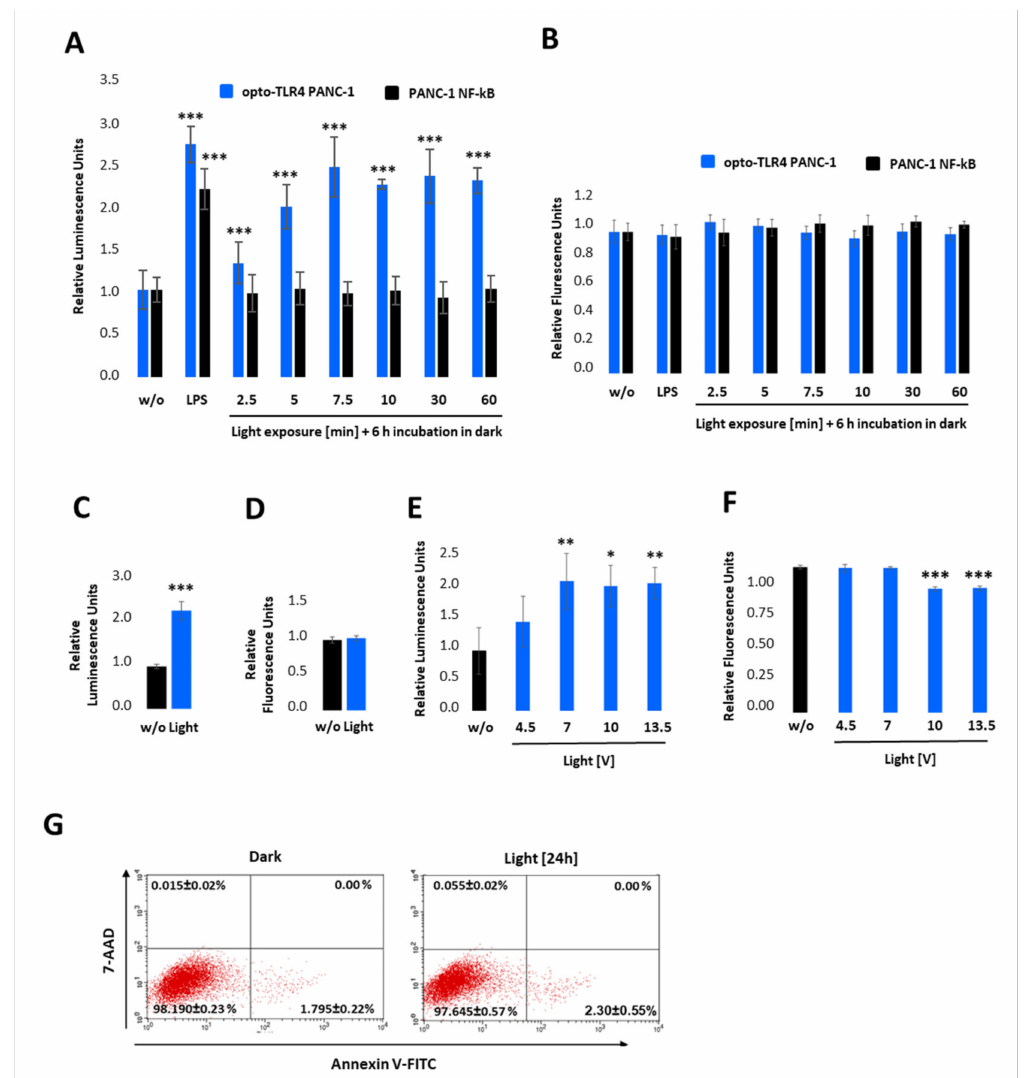
Figure 3. Characterisation of the opto-TLR4 PANC-1 cell line. TLR4-LOV homodimerisation and activation of NF- κ B in response to blue light can be detected in real-time via measuring Gaussia Luciferase (Gluc) activity. ( A , B ) Opto-TLR4 PANC-1 and PANC-1 NF- κ B were stimulated with 100 ng/mL LPS or exposed with light at 470 nm for 0, 2.5, 5.0, 7.5, 10, 30, or 60 min using the Amuza LED Array System, followed by incubation in the dark. After 6 h, ( A ) Gluc activity and ( B ) cell viability (PrestoBlue) were determined. ( C , D ) Opto-TLR4 PANC-1 cells were stimulated with light (470 nm) for 12 h, followed by ( C ) Gluc detection and ( D ) PrestoBlue. ( E , F ) Cells were illuminated with 4.5, 7.0, 10, and 13 V at 470 nm for 7.5 min, followed by incubation in the dark for 6 h and ( E ) relative NF- κ B promoter-linked Gluc and ( F ) PrestoBlue measured. Post-ANOVA multiple comparisons relative to the control were performed using Dunnett’s test. Error bar = SD. n = 6; * p < 0.05; ** p < 0.01, *** p < 0.001. ( G ) To measure cellular toxicity after light exposure, opto-TLR4 PANC-1 cell line was exposed to light (7 V, 470 nm) for 24 h, and flow cytometry analysis performed after Annexin V-Alexa Fluor 488 and 7-AAD staining. Values are means ± standard error ( n =